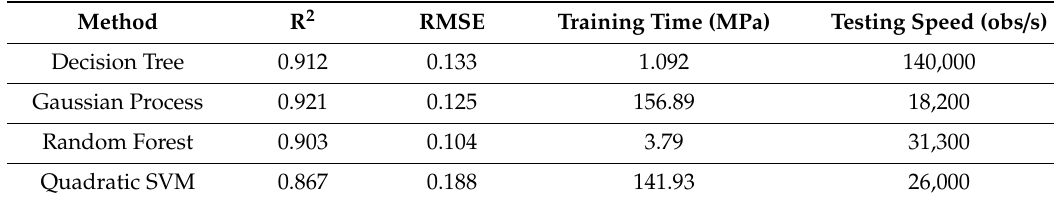
Table 4. Comparison of any model